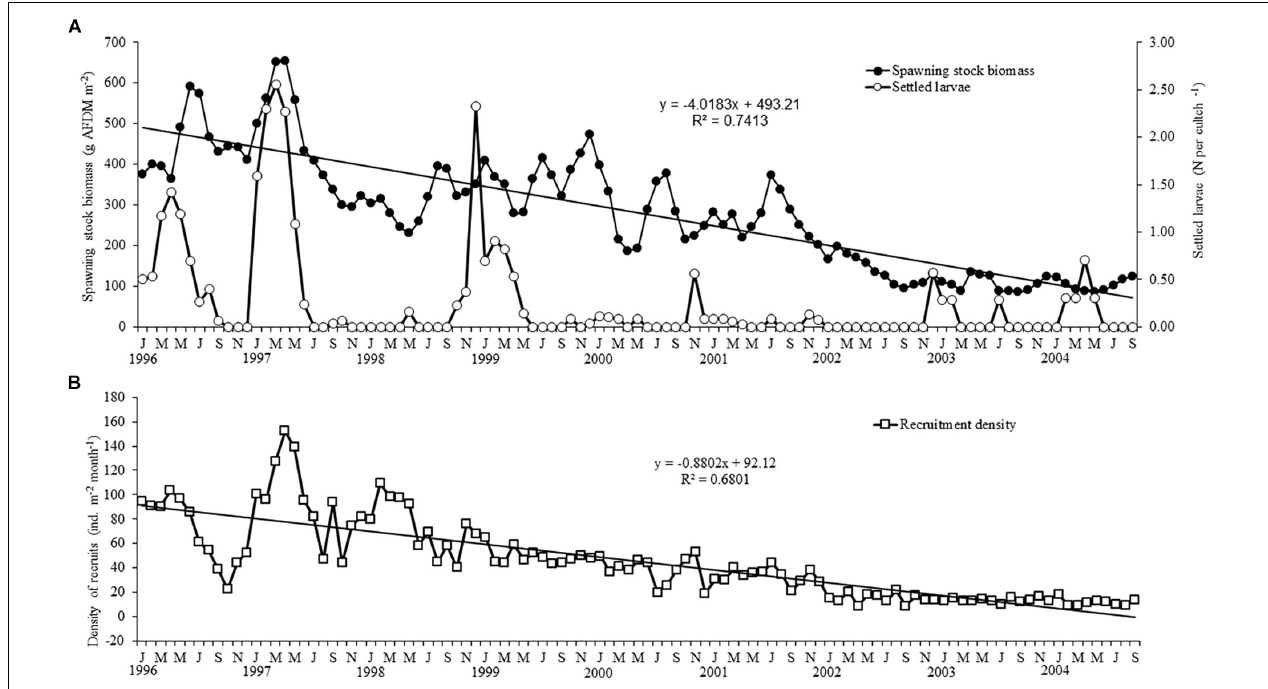
FIGURE 2 | Temporal variability of (A) the spawning stock biomass and the larval settlement and (B) the recruitment of A. atra . Data on settled postlarvae are log-transformed (Log X + 1) to avoid the overweight of a few high values and allow an easier view of the variability in the dataset.